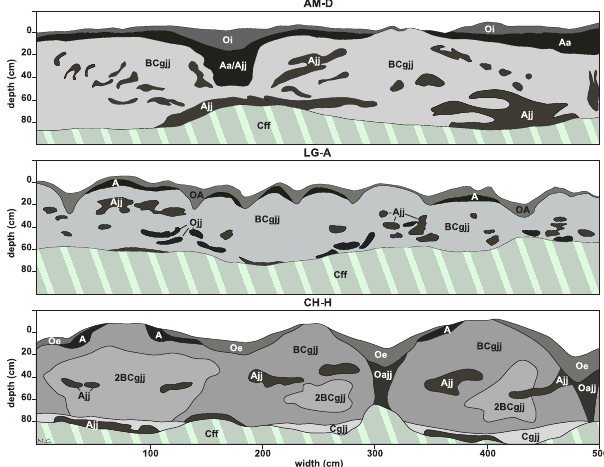
Figure 3. Selected profile maps from three different sampling sites at Cherskiy (CH), Ari-Mas (AM), and Logata (LG) (all other profile maps are presented in Fig. S7). Horizon symbols according to Keys to Soil Taxonomy (Soil Survey Staff, 2010). Note that the hatched areas (frozen zones) were not excavated, but cryoturbation also oc- curs in the upper permafrost, and subducted topsoil materials (Ojj, Ajj) can stretch into the